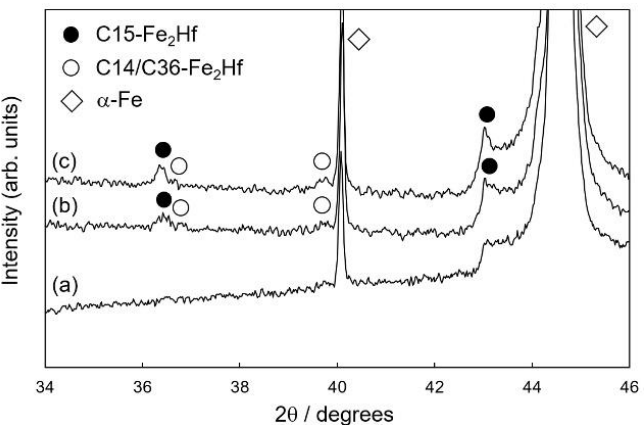
Figure 11. XRD profiles obtained from the 0.33 Hf alloy: ( a ) Before creep tests; ( b ) after creep rupture under 650 °C/60 MPa; ( c ) after creep interruption under 700 °C/30 MPa. The diffraction peaks at ~40 degrees correspond to Cu K β α-Fe (110) diffraction.